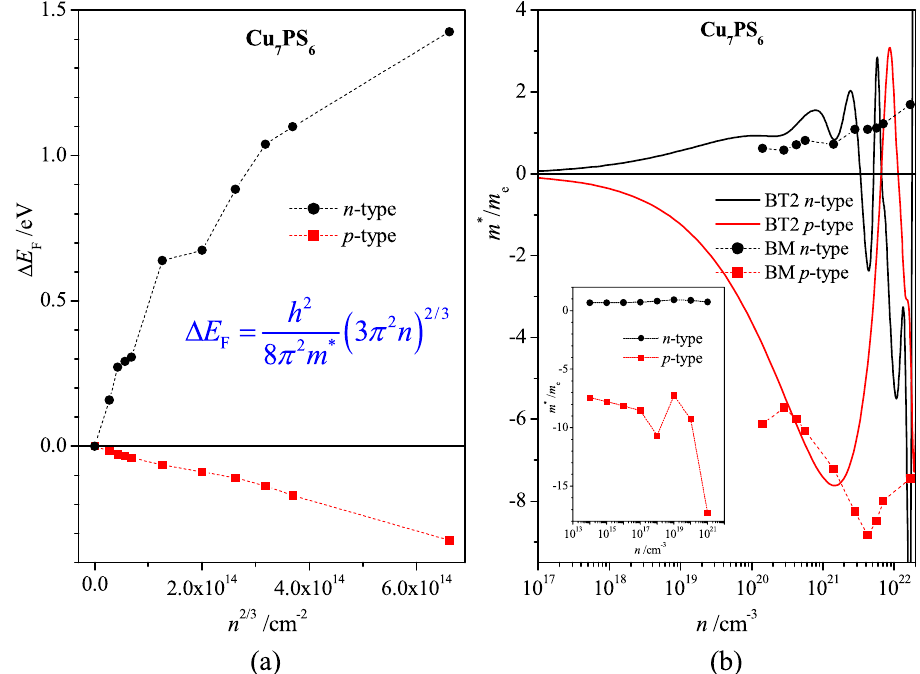
Figure 3. ( a ) Fermi level shift Δ E F as a function of the excess electron ( n -type) and hole ( p -type) concentration n 2/3 for